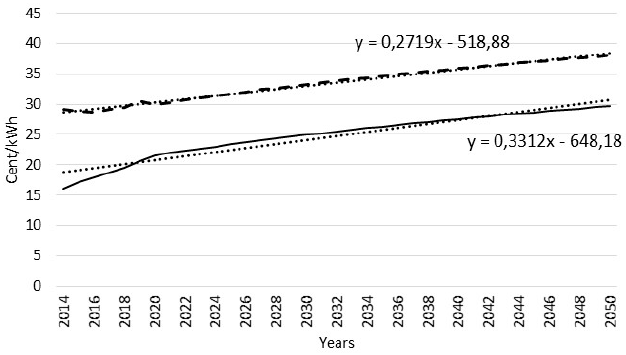
Figure 1. Electricity price development in cents / kWh with trend lines (dashed line: Germany; continuous line: Portugal).